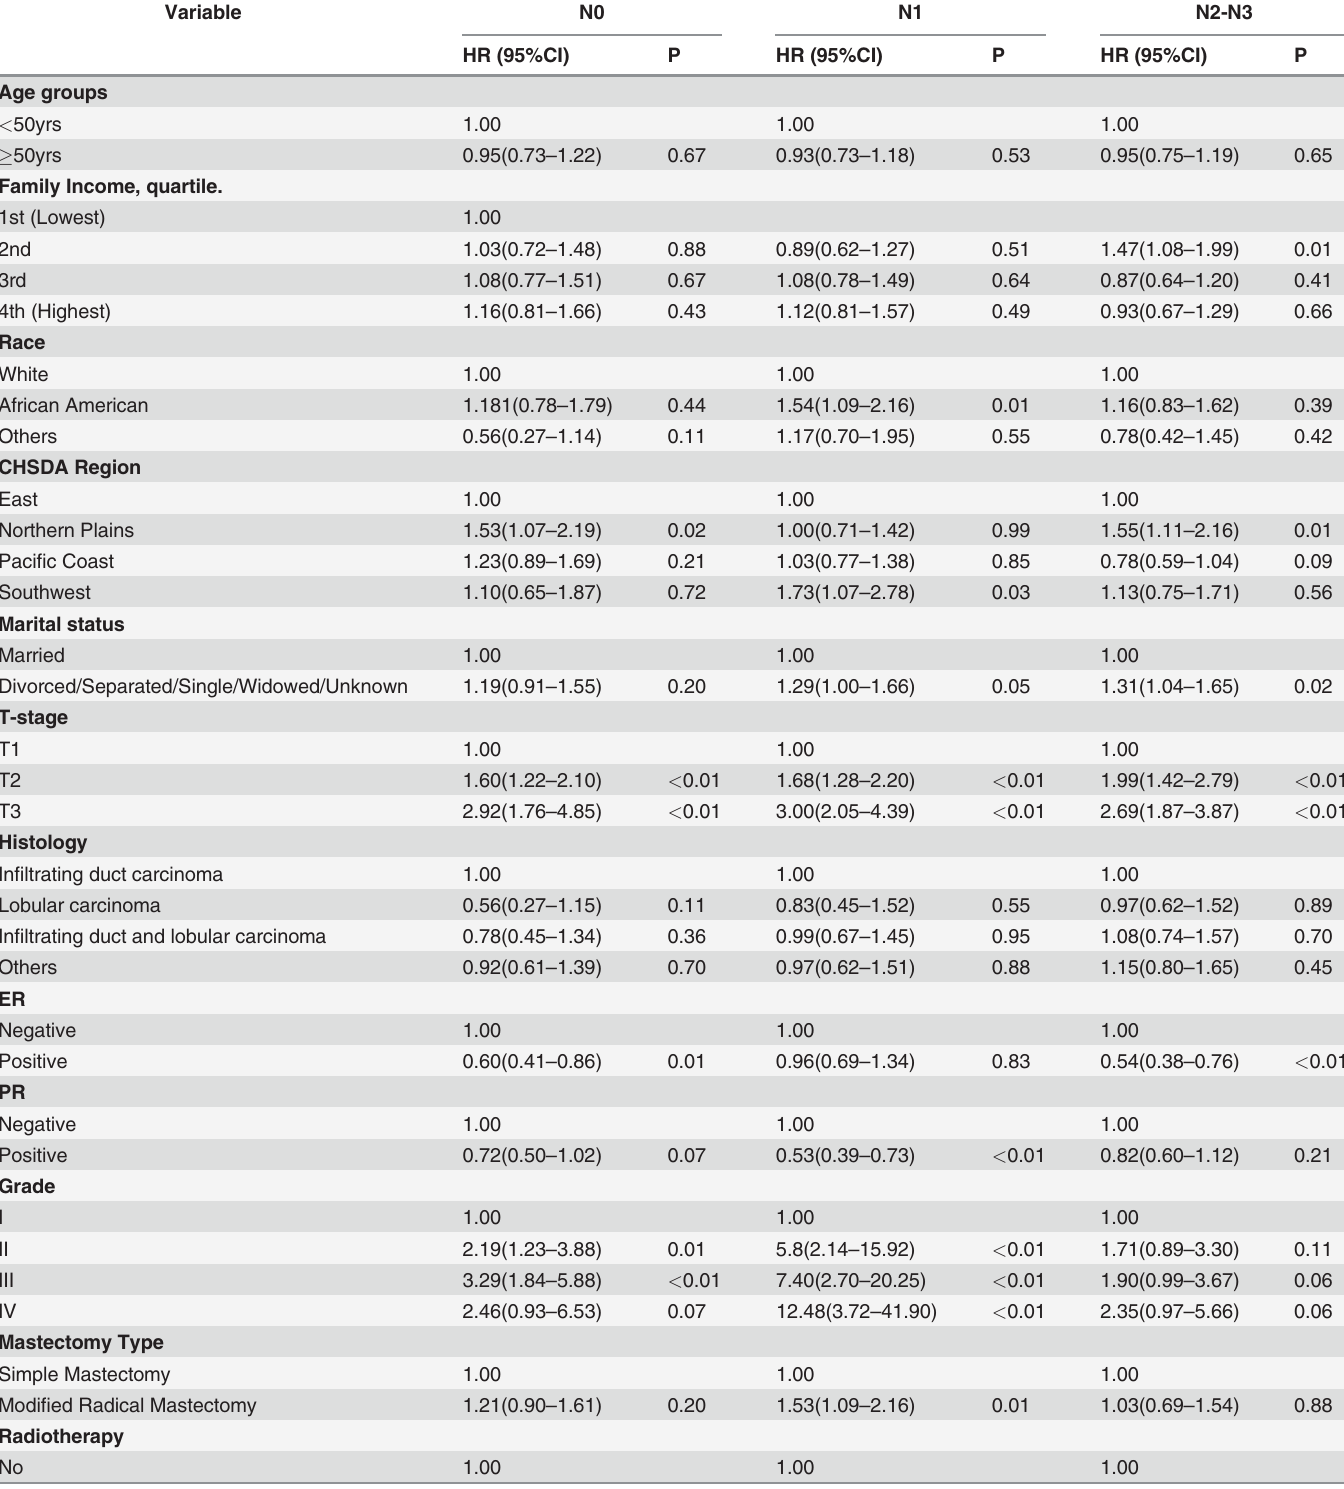
Table 2. Adjusted Cox-regression in patients with different tumor burden in the